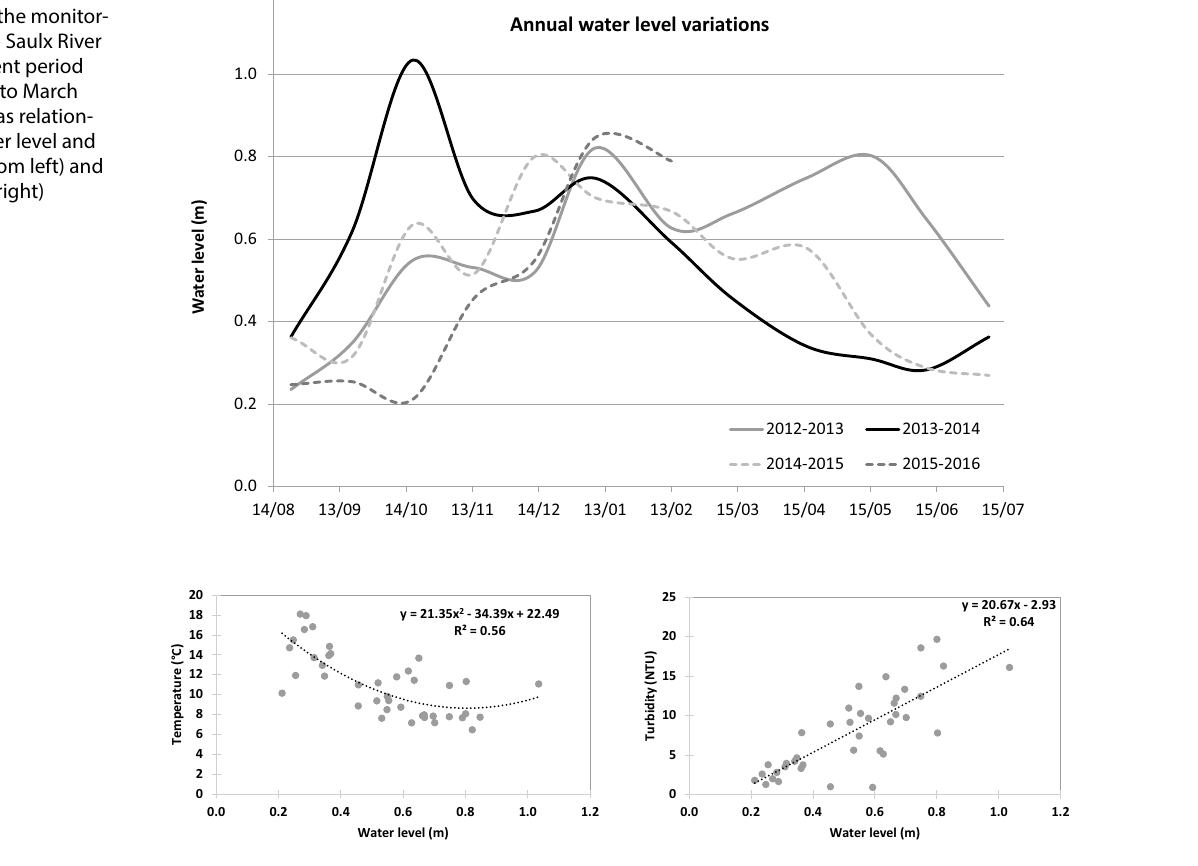
Fig. 4 Average annual water level measured at the monitor- ing stations on the Saulx River for each deployment period from August 2012 to March 2016 (top) as well as relation- ship between water level and temperature (bottom left) and turbidity (bottom